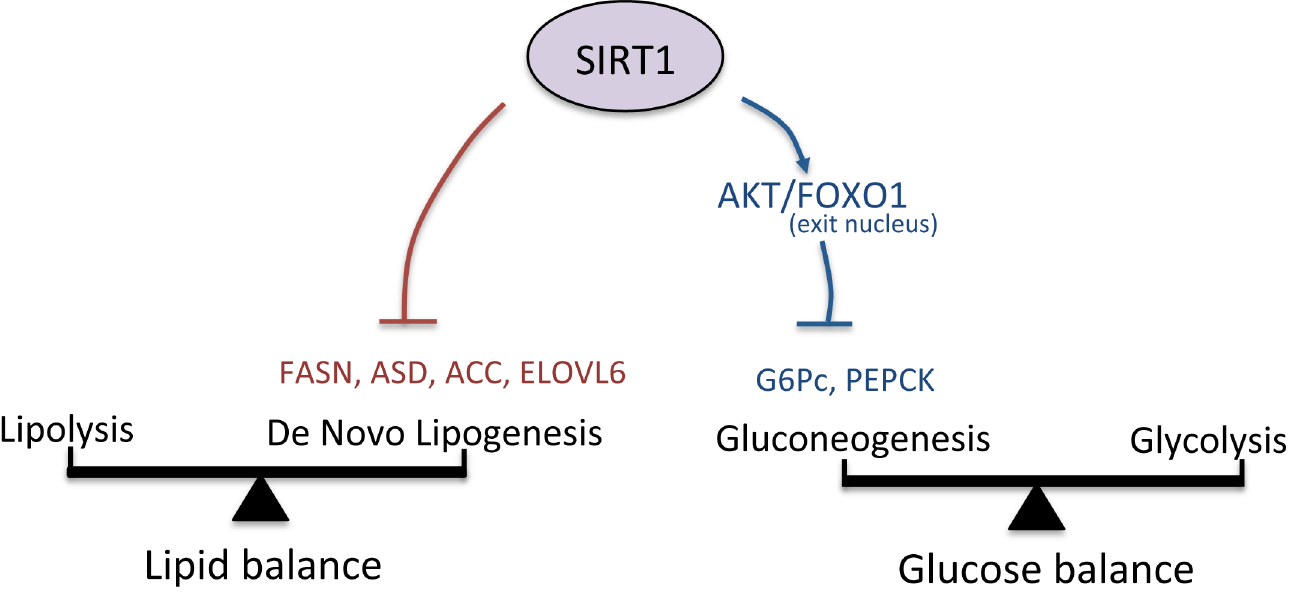
Fig 5. Representation of SIRT1 regulation of lipid and glucose balances in human fetal hepatocytes. In normal conditions, SIRT1 inhibits De Novo Lipogenesis and Gluconeogenesis through the AKT/FOXO1 pathway inside human fetal hepatocytes, keeping a normal balance inside the cells. Upon SIRT1 inhibition, both the lipid and glucose balance will be disrupted, leading to an increase of lipid and carbohydrates levels in human fetal hepatocytes.